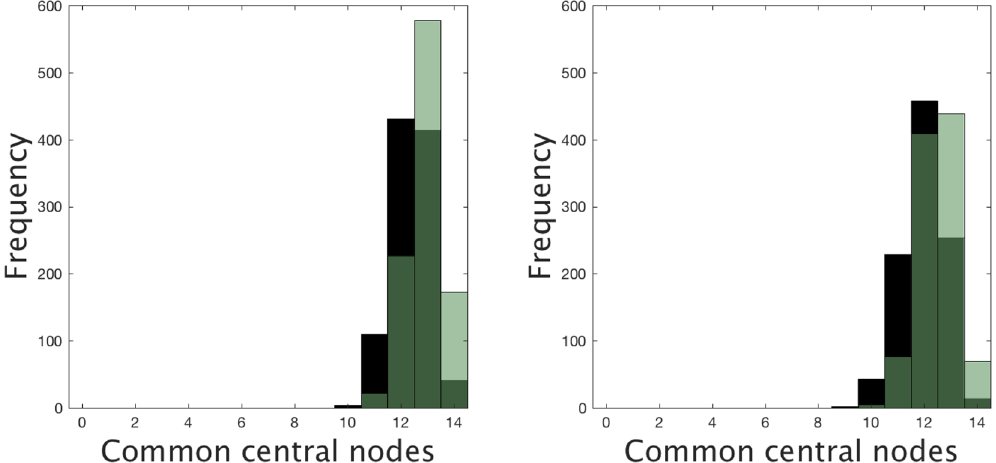
Figure 11. Frequency distribution of the number of shared central nodes under WDC selection strategy after adding 500 (green) and 1000 (black) weighted links to the original sexual network under a non-preferential random attachment (left), and under a semi-preferential random attachment (right). Overlapping areas shown in dark green. Experiment repeated 1000 times for each type of attachment and centrality measure, and taking the number of central nodes C =